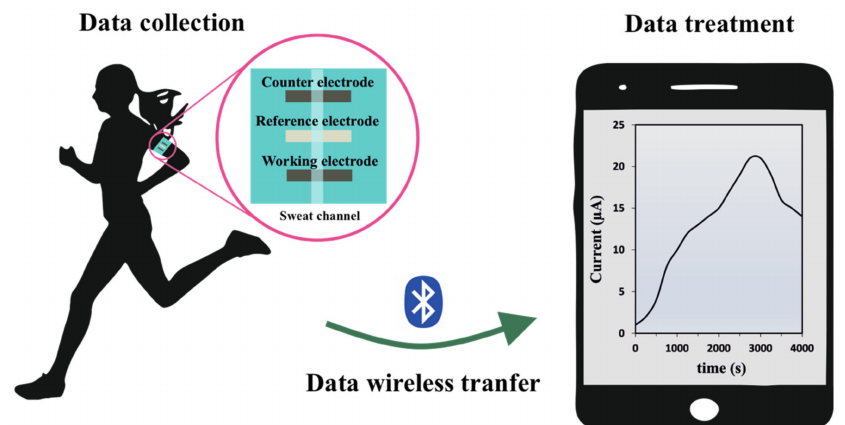
Figure 5. General scheme of the performance of a wireless wearable lactate amperometric biosensor for sweat